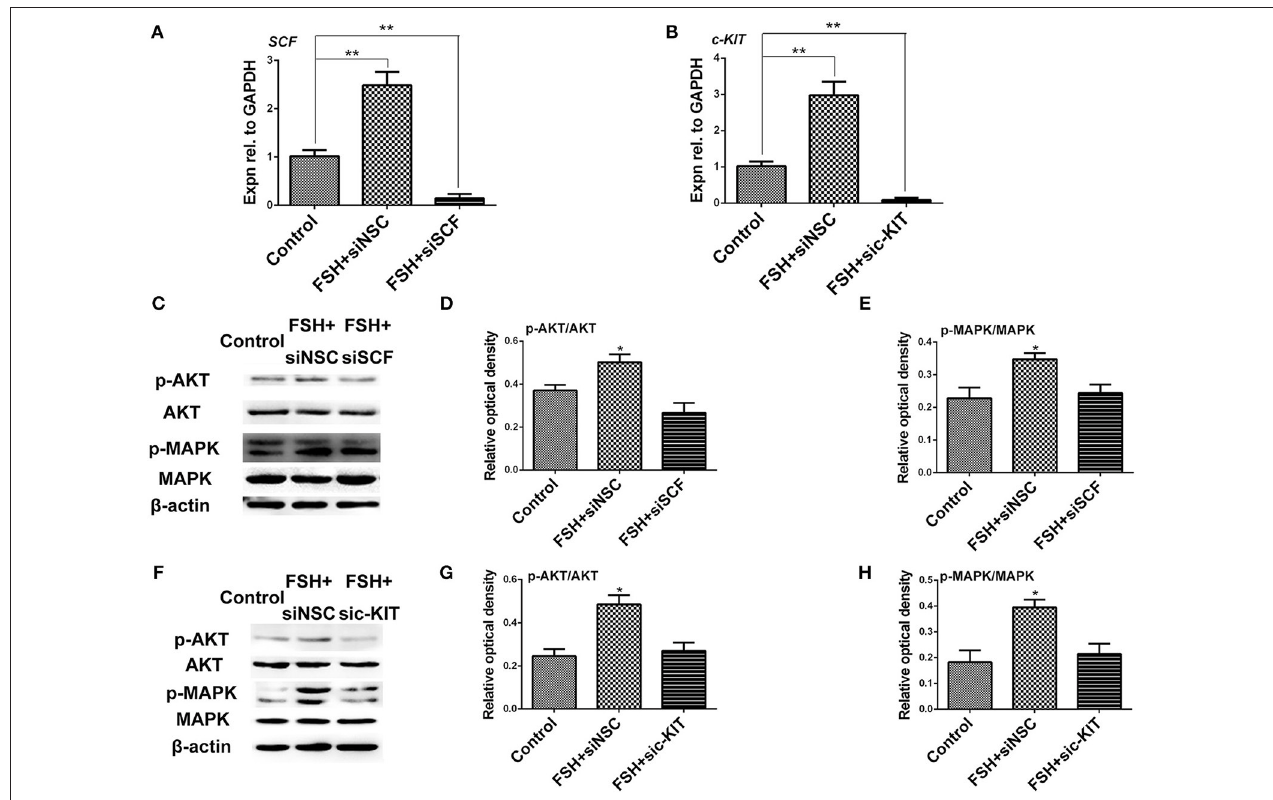
FIGURE 7 | Knockdown of SCF and c-KIT mRNAs reduced the stimulatory effect of FSH on KIT signaling. (A,B) The ovarian cells were transfected for 24h with siSCF or sic-KIT. qRT-PCR analysis indicates that siSCF or sic-KIT reduced the stimulatory effect of FSH on expression of SCF or c-KIT mRNAs. (C–E) Western blot and gray analysis indicate that siSCF reduced the stimulatory effect of FSH on ratio of p-AKT/AKT and p-MAPK/MAPK. (F–H) Treatment of sic-KIT reduced the stimulatory effect of FSH on ratio of p-AKT/AKT and p-MAPK/MAPK. “siNSC” stands for non-silencing control. T -tests were used to determine statistically significant differences. The values are the mean ± SEM of six experiments. Asterisks indicate significant differences (* P < 0.05, ** P < 0.01).